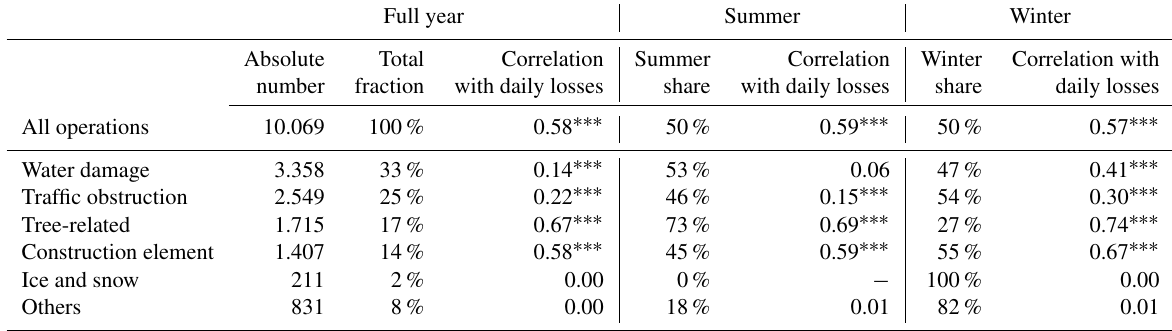
Table 1. Distributions of impacts of different types in Berlin for the period 2002–2011, stratified by their cause and by season, i.e. winter and summer half year and temporal correlations to daily building